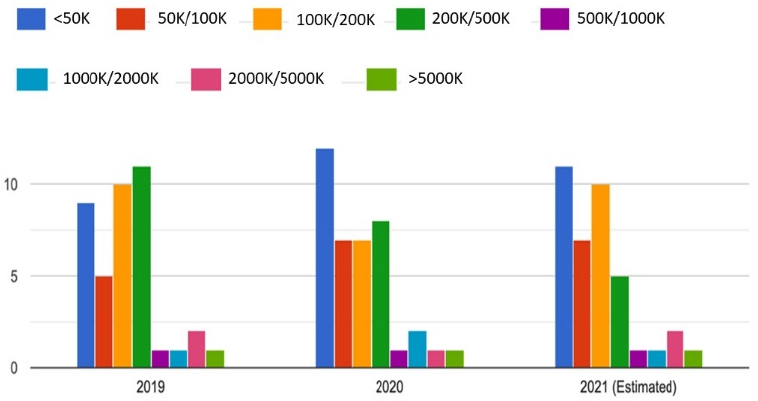
Figure 3. The total revenue by segmentation value. Data source: Survey conducted by author.